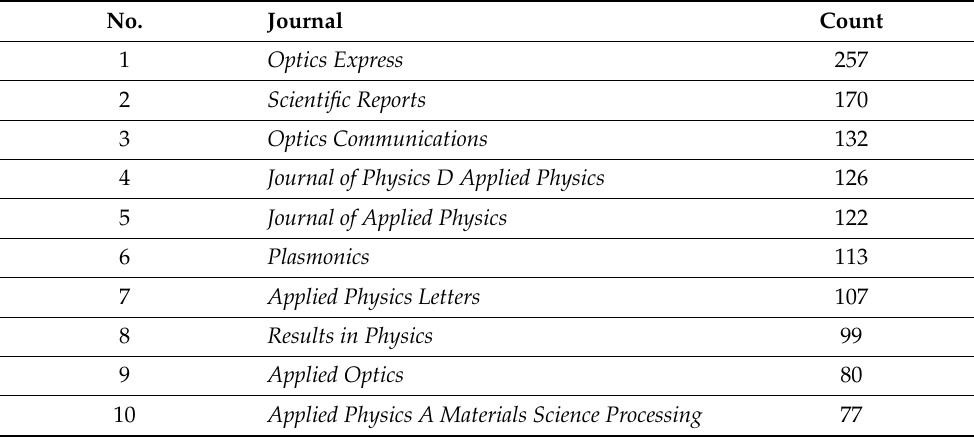
Table 5. Top ten article journals according to the number of published papers in the research. No. Count No. 1 Optics Express